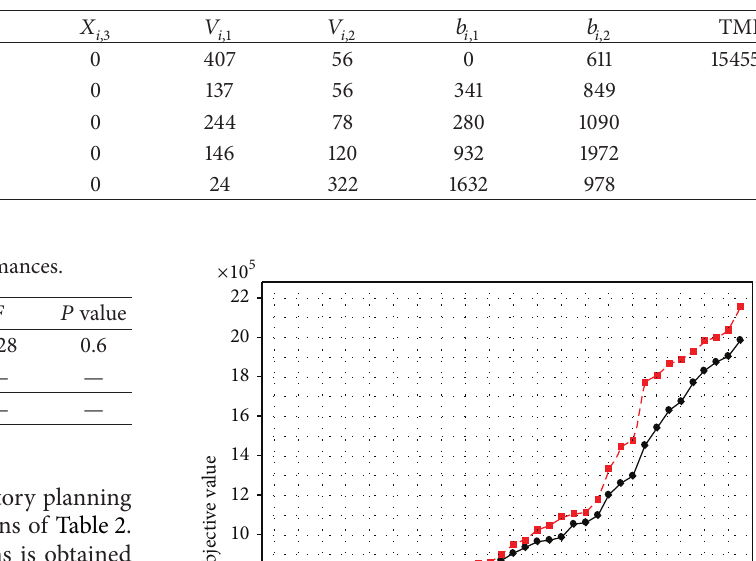
Table 8: The best result of the MOGA algorithm.